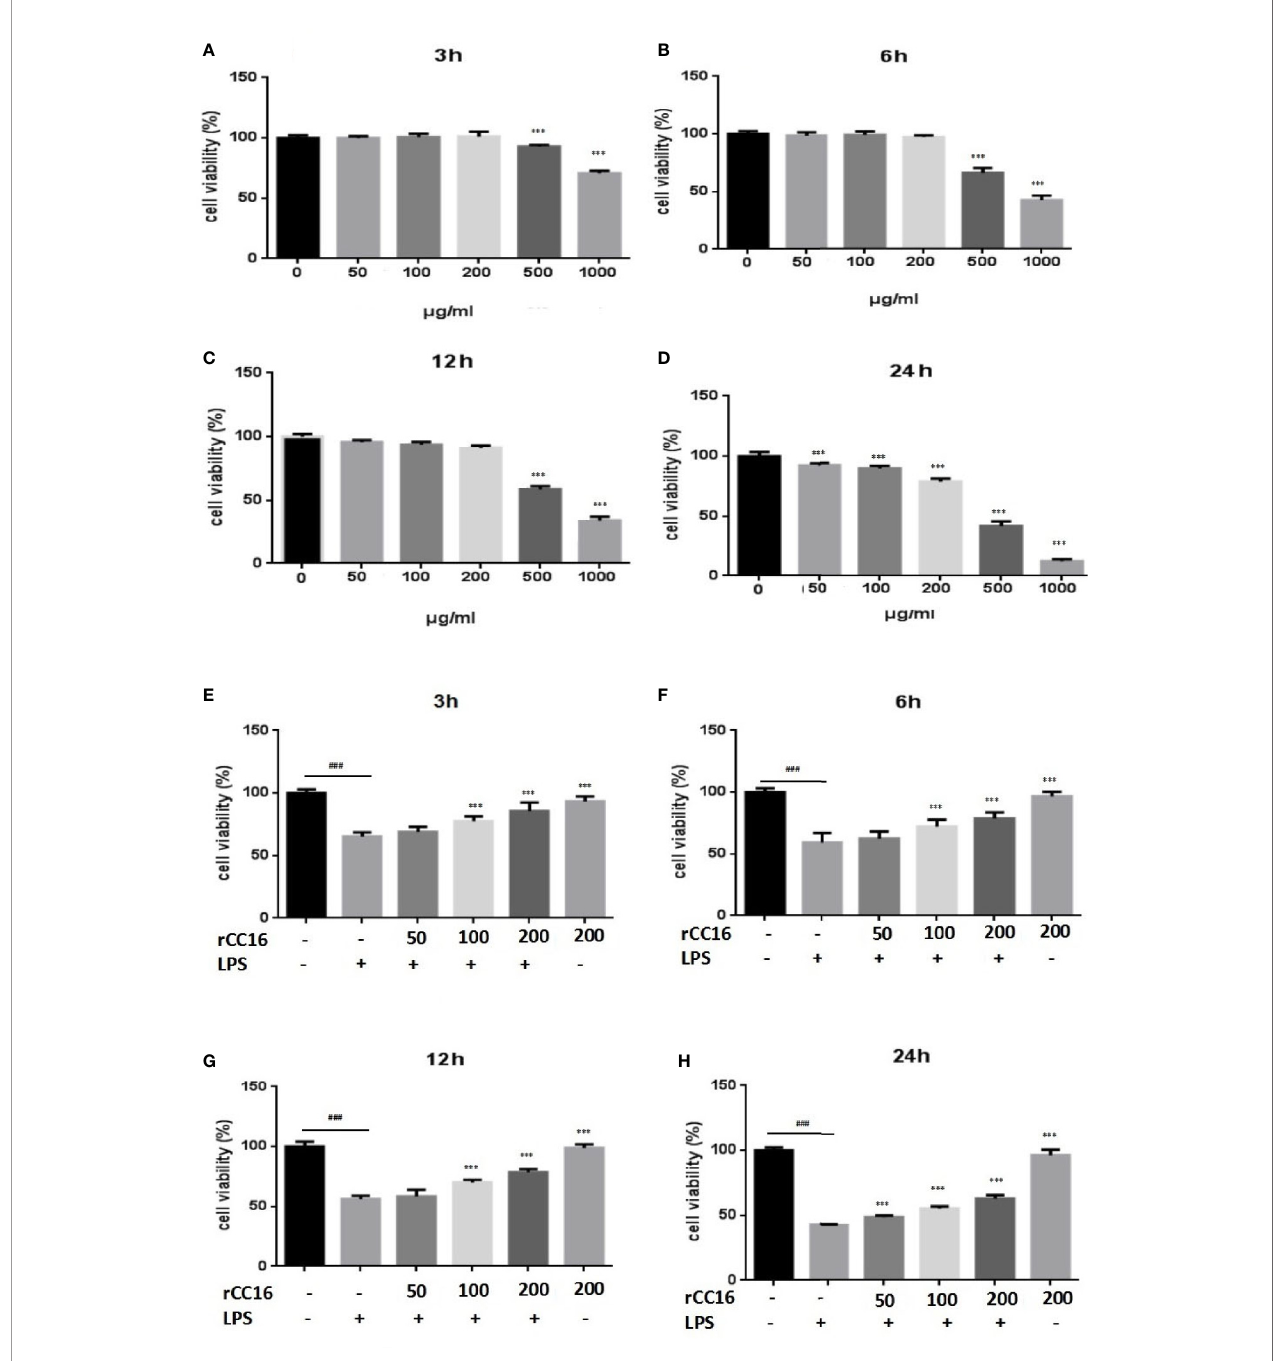
FIGURE 5 | rCC16 attenuated LPS-induced cell injury in A549 cells. (A) The effect of rCC16 on the viability of A549 cells for 3 h. (B) The effect of rCC16 on the viability of A549 cells for 6 h. (C) The effect of rCC16 on the viability of A549 cells for 12 h. (D) The effect of rCC16 on the viability of A549 cells for 24 h. (E) The effect of rCC16 on LPS-induced cell viability loss for 3 h; cells were pretreated with different concentrations of rCC16 for 12 h and then incubated with or without 200 m g/ml LPS for an additional 3 h. (F) The effect of rCC16 on LPS-induced cell viability loss for 6 h; cells were pretreated with different concentrations of rCC16 for 12 h and then incubated with or without 200 m g/ml LPS for an additional 6 h. (G) The effect of rCC16 on LPS-induced cell viability loss for 12 h; cells were pretreated with different concentrations of rCC16 for 12 h and then incubated with or without 200 m g/ml LPS for an additional 12 h. (H) The effect of rCC16 on LPS- induced cell viability loss for 12 h; cells were pretreated with different concentrations of rCC16 for 24 h and then incubated with or without 200 m g/ml LPS for an additional 24 h. The data are expressed as the mean ± SD; ### p < 0.001 compared with the untreated group; *p < 0.05, **p < 0.01, and ***p < 0.001 compared with the LPS group. Graphs show the mean ± SD of triplicate wells and represent three independent